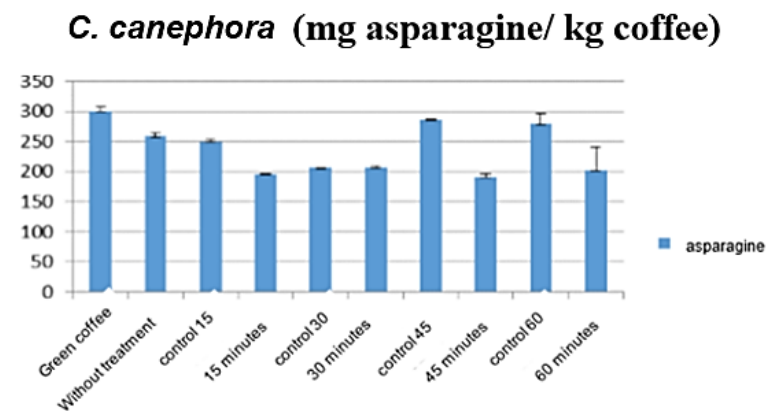
Figure 1. Influence of pretreatment with steam in C. arabica .